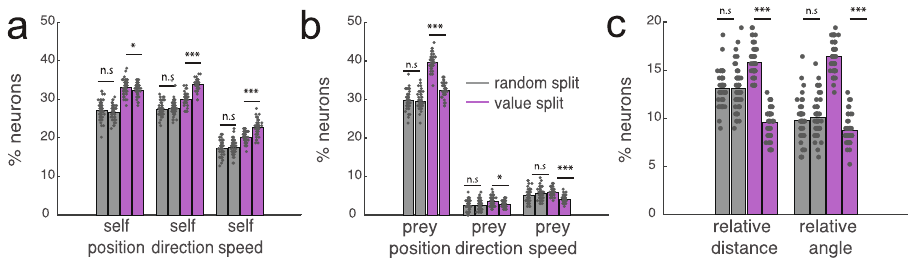
Fig. 8 Tuning for task variables change with prospective reward. These data support the idea of mixed selectivity. a The number of tuned neurons for self variables (self position, self direction, and self speed) when splitting data randomly (gray bar) or according to value of pursued prey (purple bar). Splitting by value increases proportion of tuned neurons, indicating that value modulates responding in a systematic way. b The number of signi fi cantly tuned neurons for prey variables (prey position, prey direction, and prey speed) when splitting data randomly (gray bar) or according to value of pursued prey (purple bar). The difference of value split was signi fi cant ( p = 0.0221 for prey speed, and p < 0.001 for other prey variables), but not for random split. For the prey analysis, only single prey trial is included to reduce confounding (i.e., pursuing targets, transition of pursuit-avoidance behavior). c The number of signi fi cantly tuned neurons for egocentric (self position, self direction, and self speed) when splitting data randomly (gray bar) or according to value of pursued prey (purple bar). The difference of value split was signi fi cant ( p < 0.001). We observed a difference in numbers of signi fi cantly tuned neurons between split data. This process was repeated for 50 times by bootstrapping. Signi fi cance was calculated by two-sided sign-rank test. n.s means it is not signi fi cant, and *** indicates p < 0.001.